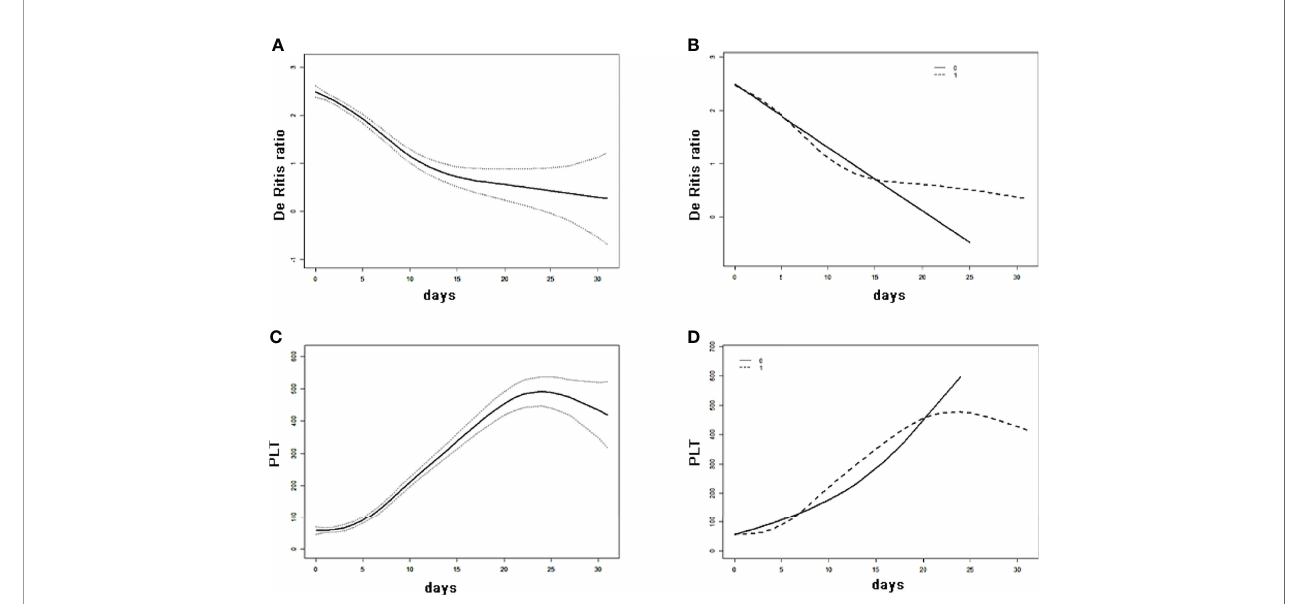
FIGURE 4 | Shift trend of De Ritis ratio and PLT of SFTS patients analyzed by GAMM. (A) The overall change of De Ritis ratio in 107 SFTS patients. (B) The change of De Ritis ratio in SFTS patients treated/untreated with ribavirin. (C) The overall change in PLT within 107 SFTS patients. (D) The change of PLT in SFTS patients treated/untreated with